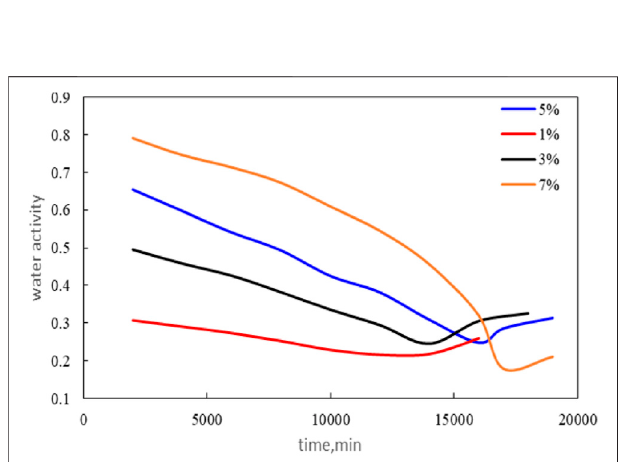
FIGURE 11 | Comparison of the subcooling degree of inhibitor at different concentrations at 10 MPa.